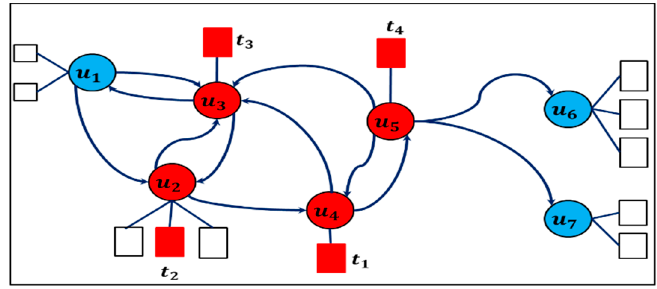
Figure 26. The diffusion process of a particular information I in a SN (Ref. [112]). Figure 26. The di ff usion process of a particular information I in a SN (Ref.